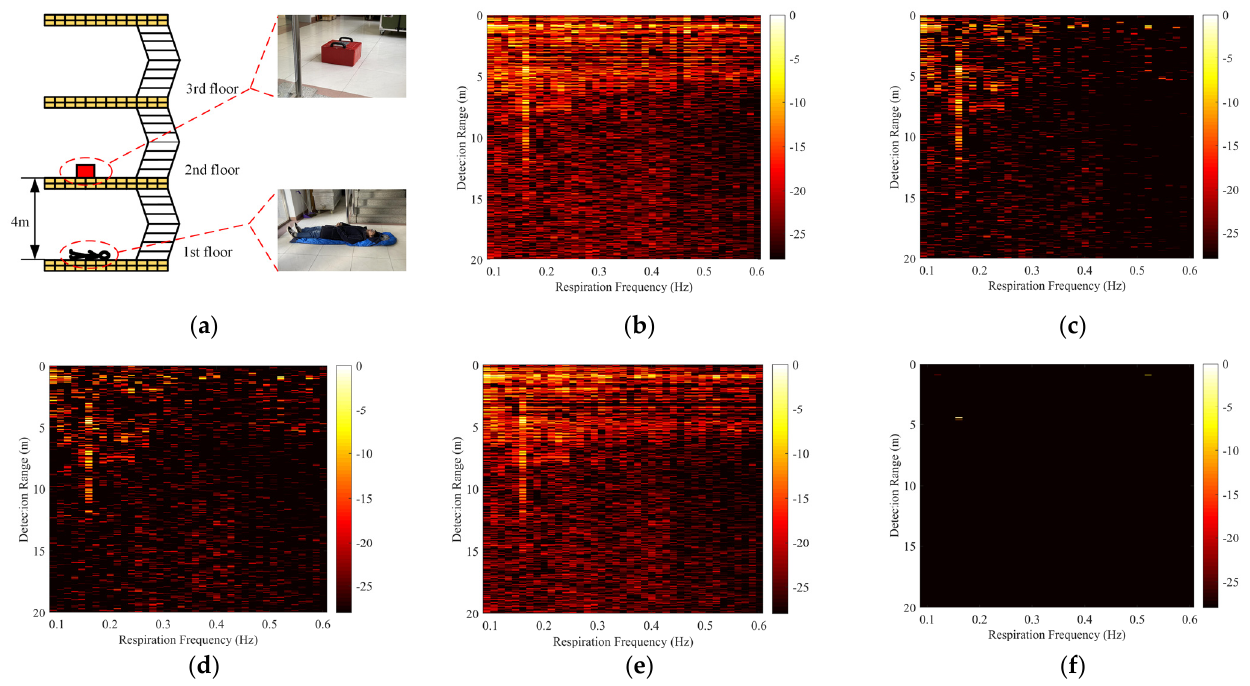
Figure 12. Realistic through-one-floor detection scenario and results. ( a ) The realistic through-one-floor detection scenario, ( b ) the direct FFT result, ( c ) the result processed by MS, ( d ) the result processed by SVD, ( e ) the result processed by the method in [36], and ( f ) the result processed by our method, where λ = 0.3.